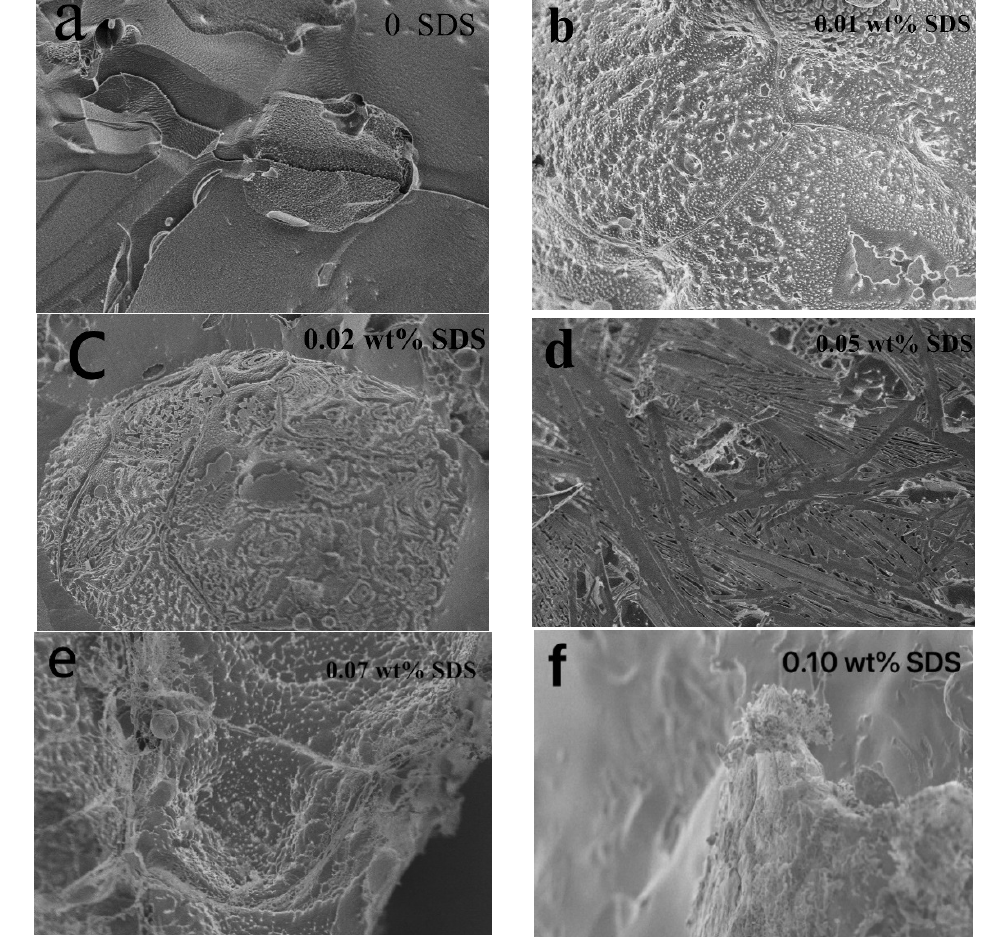
Figure 6. The pictures were observed by SEM for CO 2 hydrate. ( a ) 0 wt% SDS ( b ) 0.01 wt% SDS ( c ) 0.02 wt% SDS ( d ) 0.05 wt% SDS ( e ) 0.07 wt% SDS ( f ) 0.10 wt% SDS